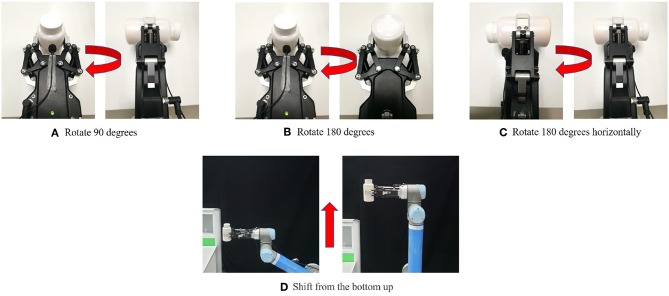
Interaction actions.